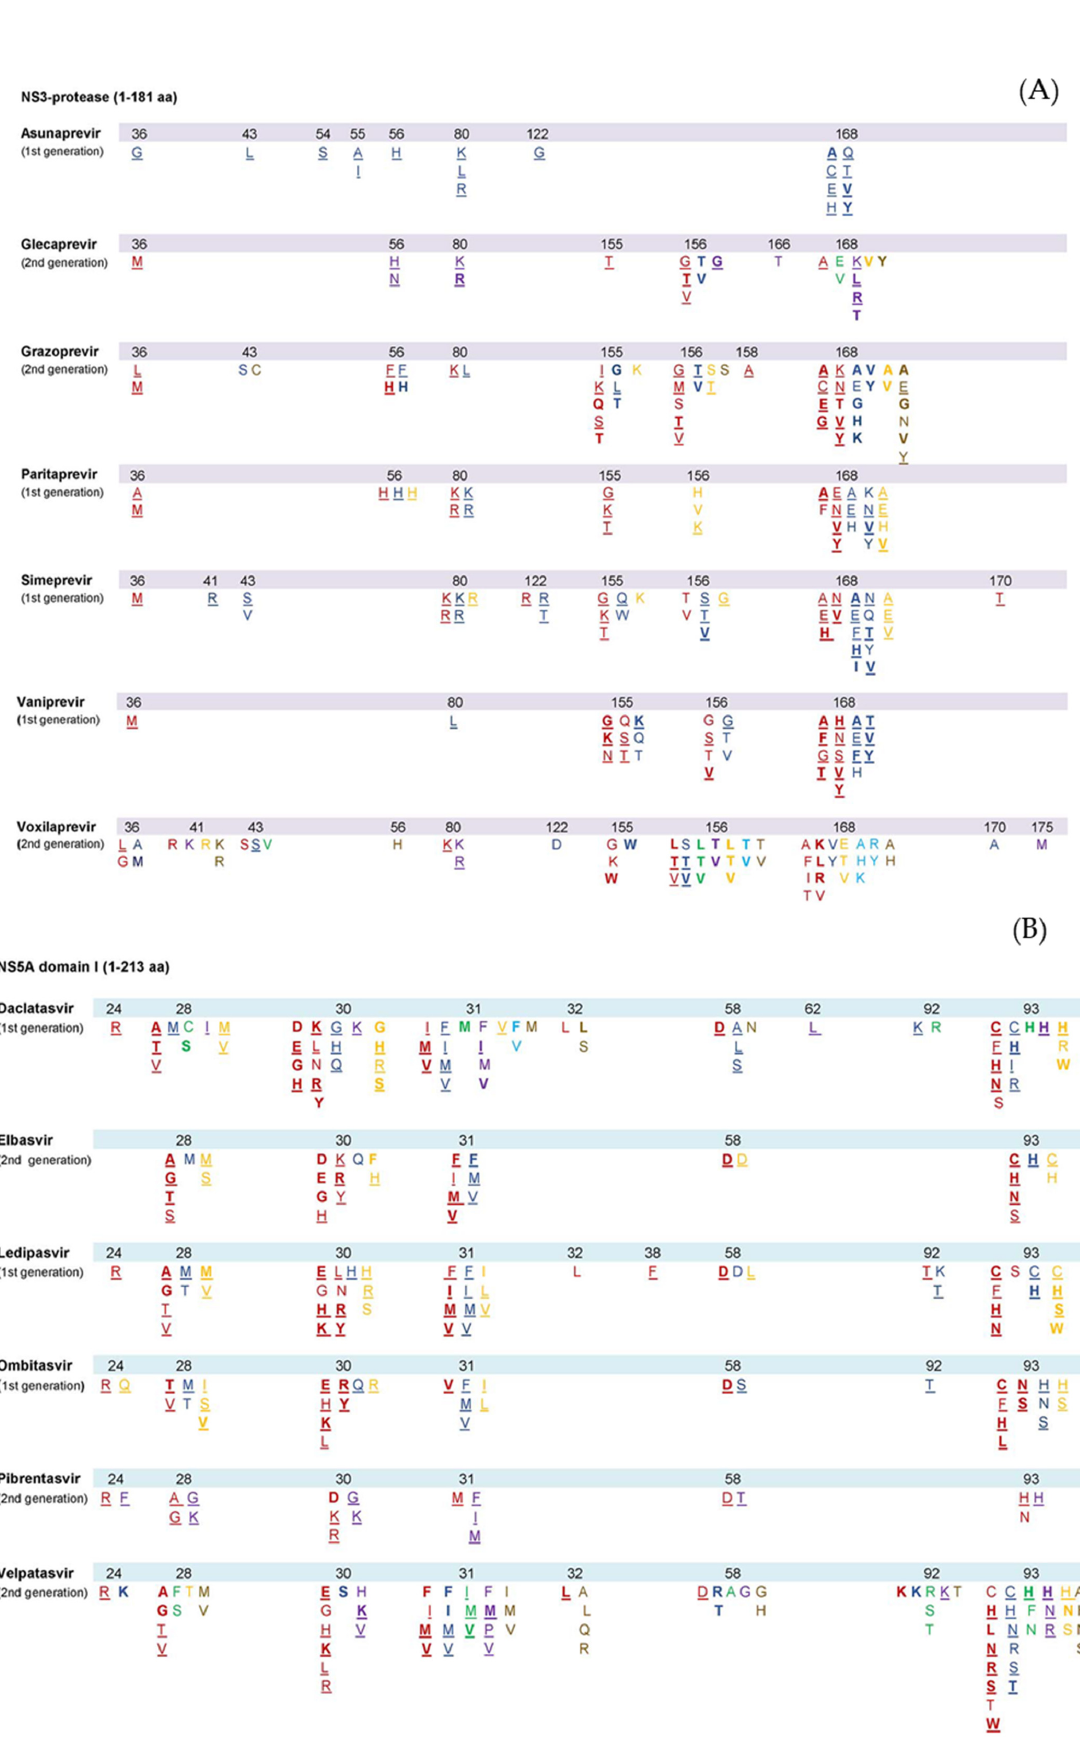
Figure 2. Summary of the substitutions associated with resistance to protease inhibitors ( A ), NS5A inhibitors ( B ) and nucleoScheme 5. B inhibitors ( C ). HCV genotypes and subtypes are represented by different colors: 1a–red, 1b-blue, 2a/b/c–green, 3a–purple, 4a/d–yellow, 5–light blue, 6–brown. Amino acid substitutions detected in vivo in DAA failing patients are underlined, independently of in vitro data information. From Ref. [28]; Sorbo, M.C.; et al. Drug Resistance Updates 2018; 37, 17–39 (permission from the original copyright holder). 3.1. Simeprevir, SIM In genotype 1 patients, simeprevir demonstrates increased cross-resistance with other first generation NS3 protease inhibitors [33]. In patients with GT1a, R155K/G/T, V36M, S122R, Q80K/R and D168A/E/H/V substitutions have been linked to treatment failure. Furthermore, substitutions at position 122 (S122R/T) as well as 168